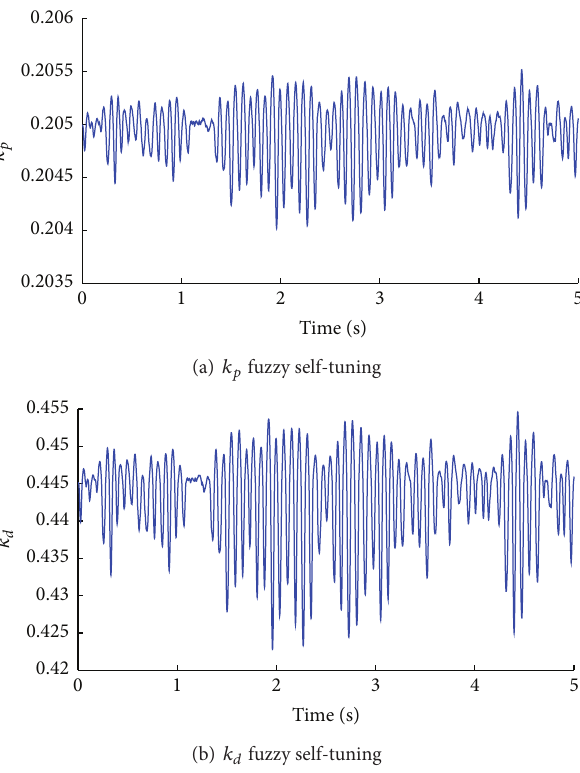
Figure 10: Fuzzy self-tuning of controller parameters with white noise